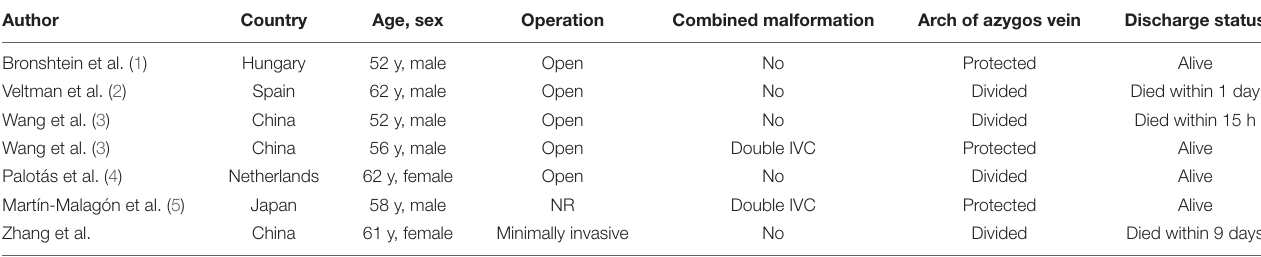
TABLE 1 | Reported cases of azygos continuation of the inferior vena cava in patients undergoing